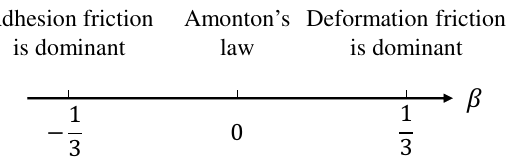
Figure 1. Relationship between the exponent β and the frictional